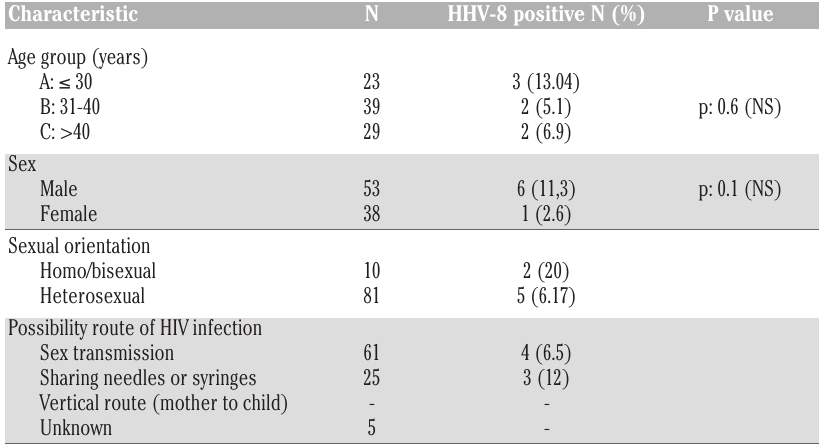
Table 1. Determinants of HHV-8 antibodies in HIV-infected